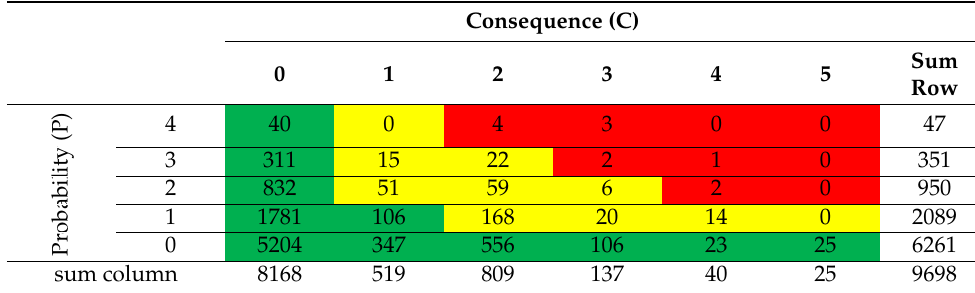
Table A6. Risk matrix based on LCI and flow at time